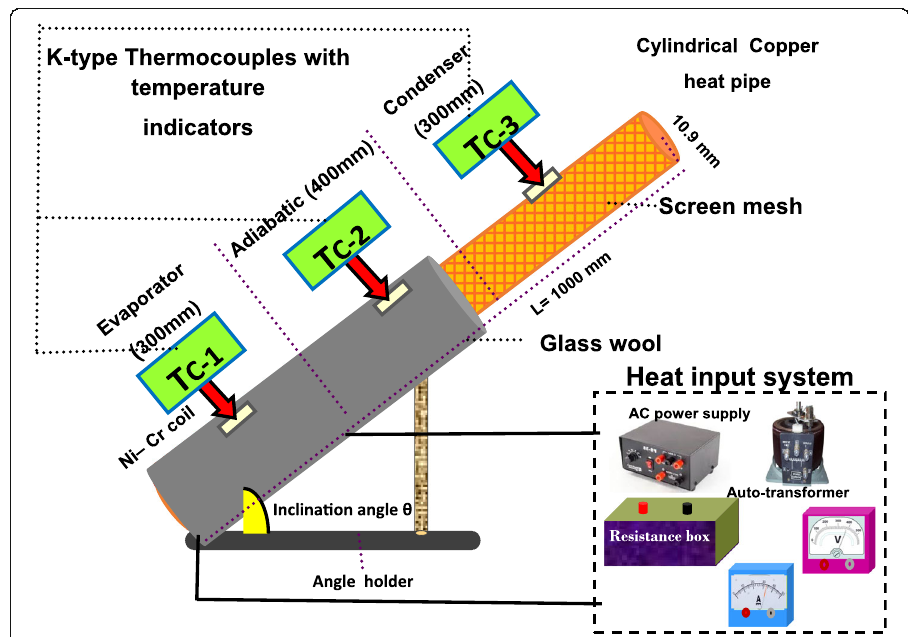
Fig. 1 Schematic of experimental heat pipe